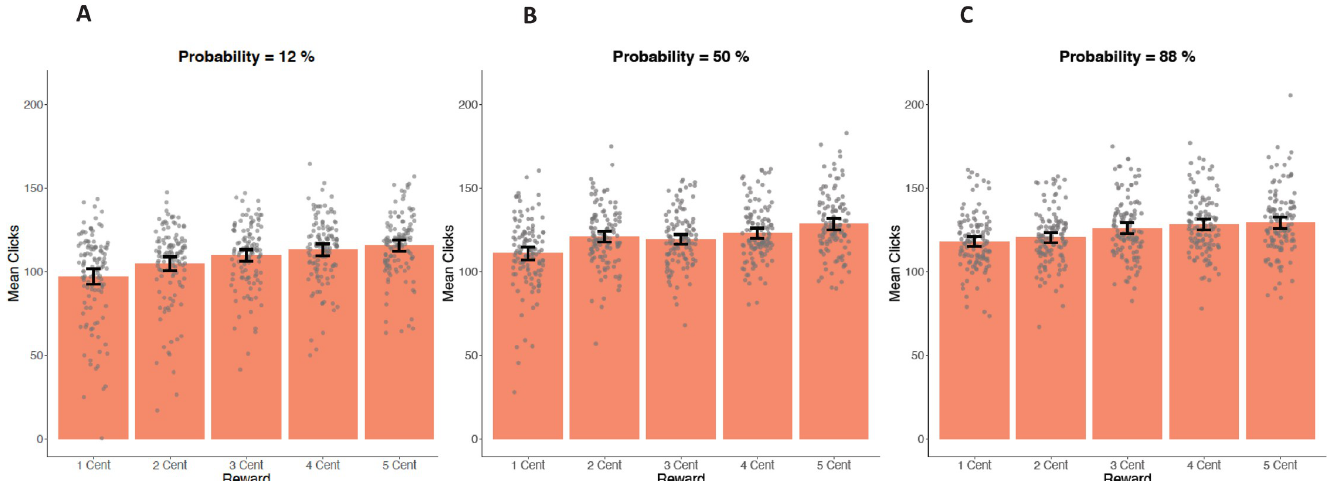
Fig 4. Mean number of clicks within the modified EEfRT in Study 1. Comparison of trials with low probability of reward attainment (left; A ), medium probability of reward attainment (middle; B ) and high probability of reward attainment (right; C) within the modified EEfRT. For each probability category all 5 different reward magnitudes (ranging from 1 cent (most left) to 5 cent (most right) are displayed. Data points are added as dots for individual scores. Error bars depict a 95% confidence interval (CI) of the mean.